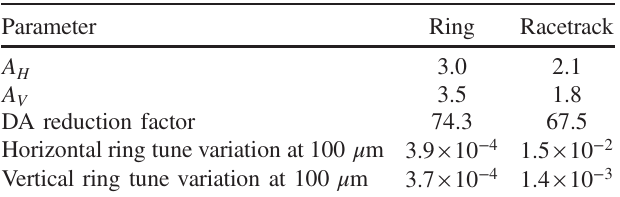
TABLE V. A comparison of the COD amplification factors, DA reduction factor and rms tune variation from the mean for 100 μ m misalignment errors for the ring and racetrack lattices. A A H and V refer to the horizontal and vertical amplification factors, respectively.